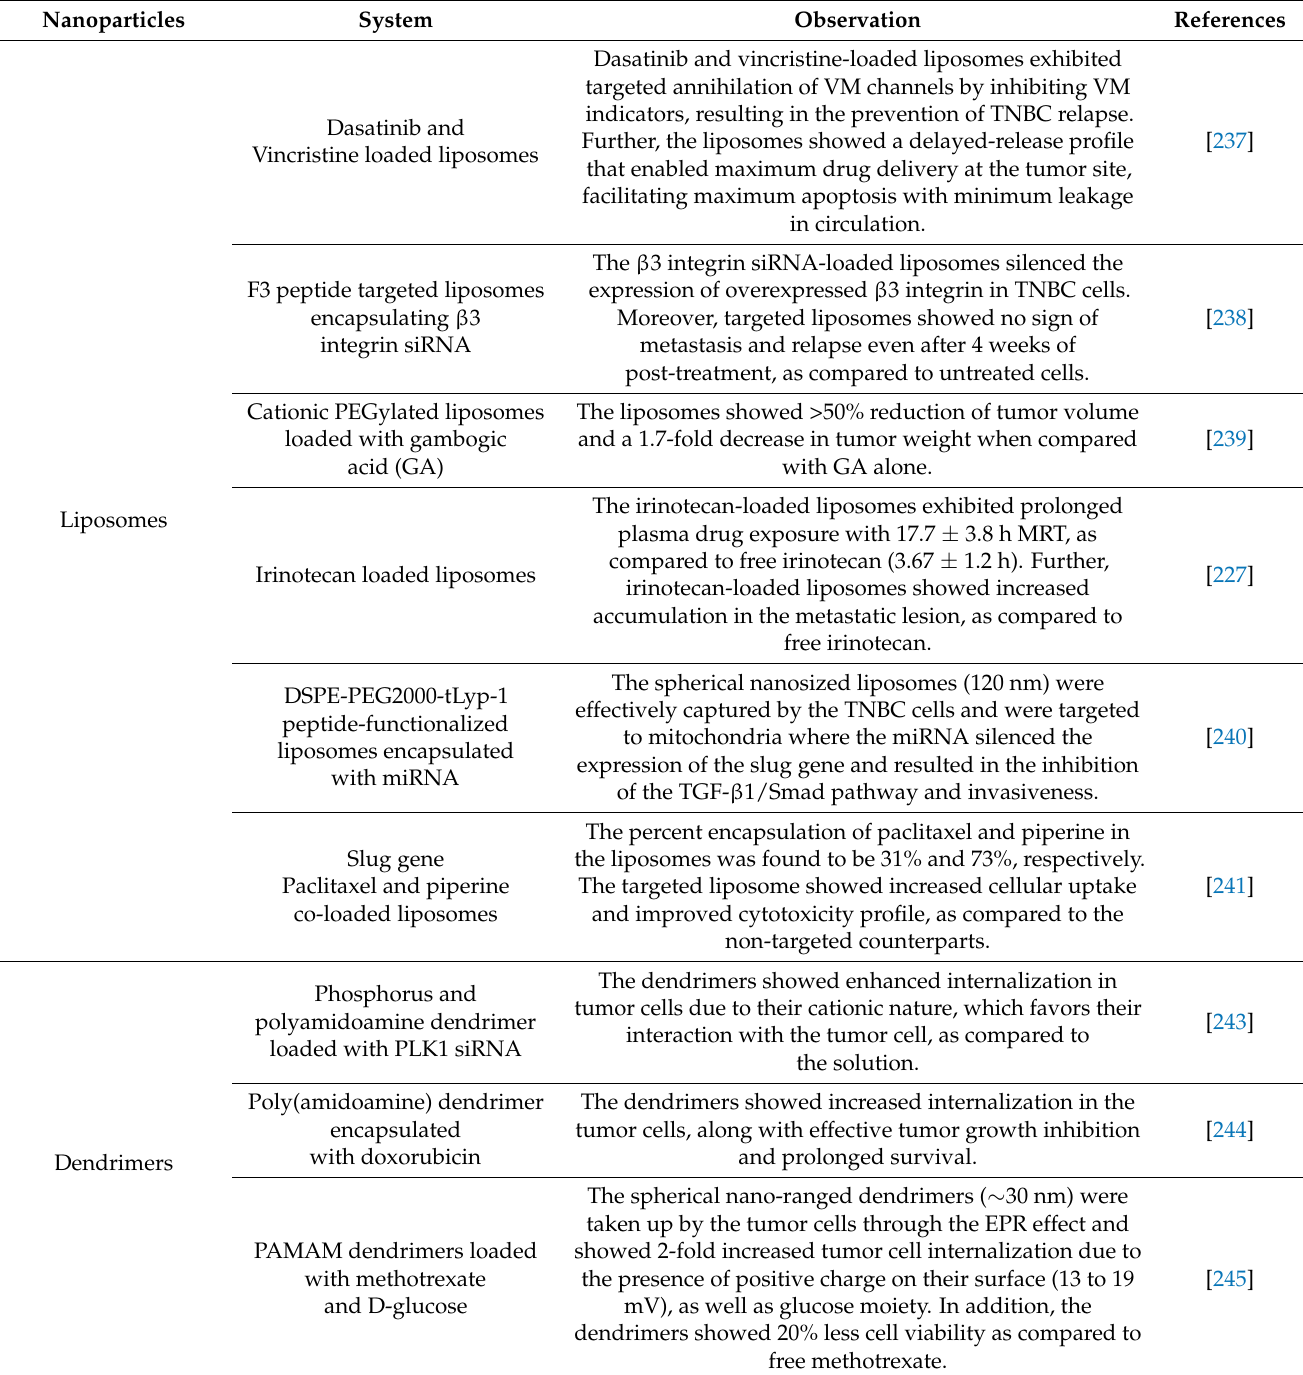
Table 3. The various nanoformulations were fabricated to enhance the therapeutic efficacy over the conventional formulations in offsetting